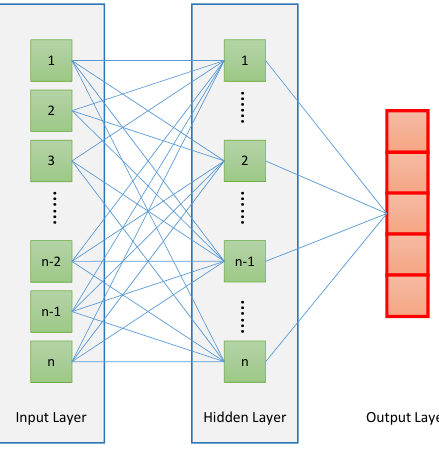
Figure 4. The architecture of the proposed Artificial Neural Network (ANN)